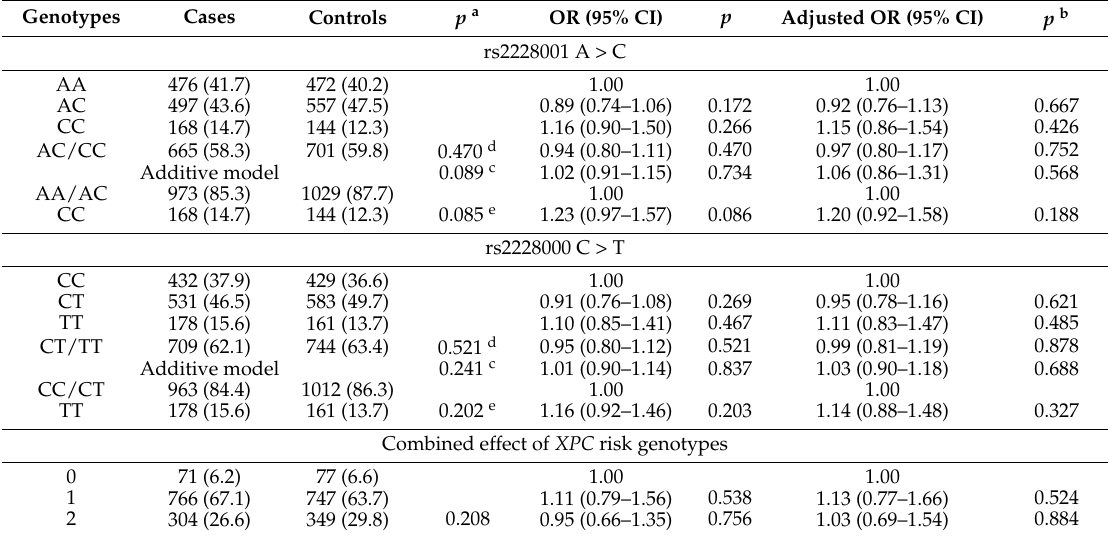
Table 2. Associations between xeroderma pigmentosum group C ( XPC ) gene polymorphisms and colorectal cancer